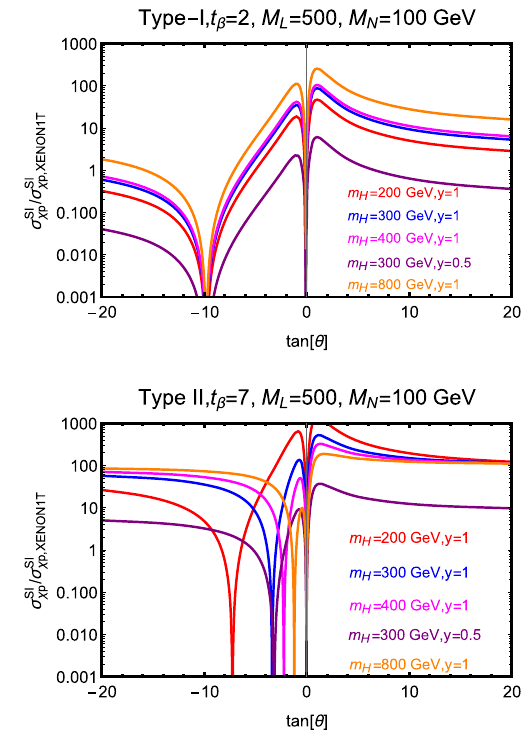
Fig. 3 Ratio of SI Direct Detection cross-section over the current limit value, as function of tan θ for Type-I (upper), Type-II (bottom panel) models and for some assignations of m H and y , reported in the plots. In all cases we have fixed M L = 500GeV and M N =